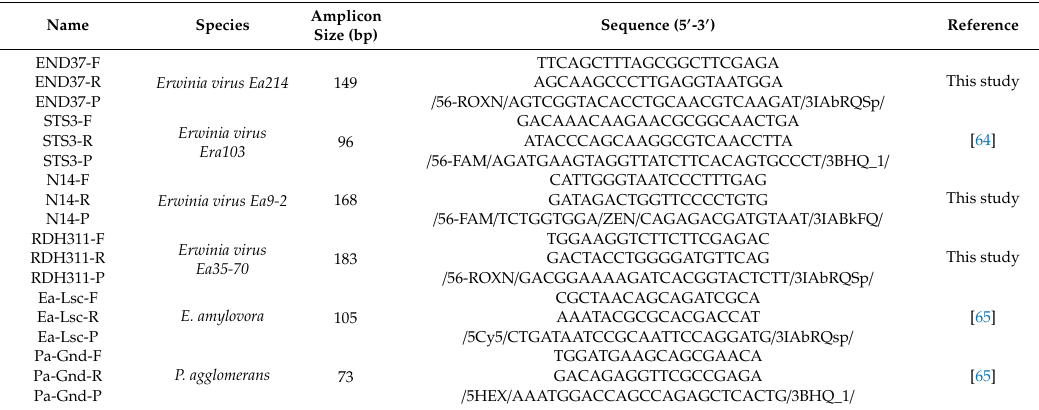
Table 3. Primers and probes used for real-time qPCR.